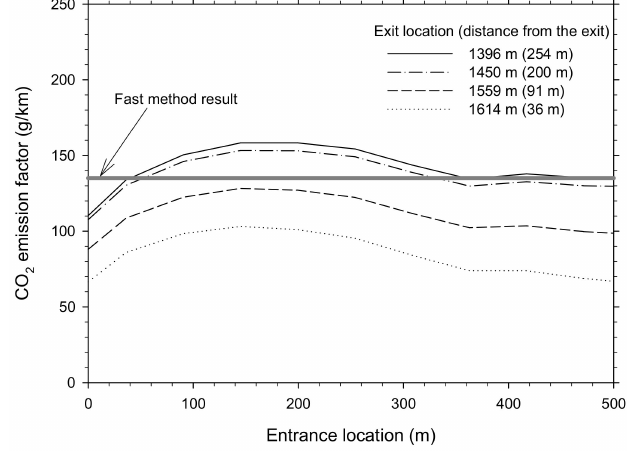
Figure 6. Changes in CO 2 emission factors estimated by the traditional method with the mobile laboratory data measured inside the Jeongneung Tunnel on 8